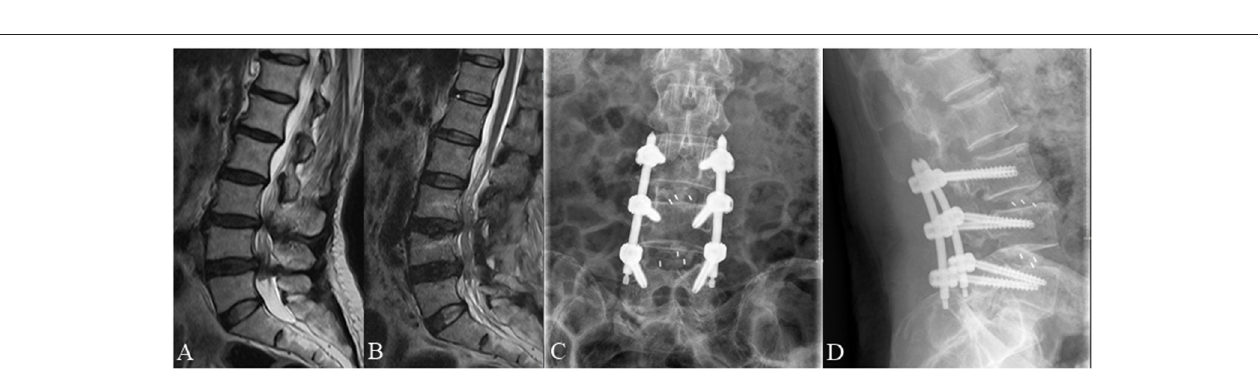
FIGURE 4 | A 66 year old female complained of low back pain for 3 months underwent posterior lumbar decompression and instrumented interbody fusion at L4/5. (A) Pre-operative lumbar MRI showed that the nerve roots were redundant above the L4/5 intervertebral disc. (B) Post-operative lumbar MRI obtained 3 days after surgery demonstrated significant relief of RNRs. (C,D) Lumbar radiographs obtained 3 months after surgery demonstrate internal fixation in good position without cage subsidence or migration.